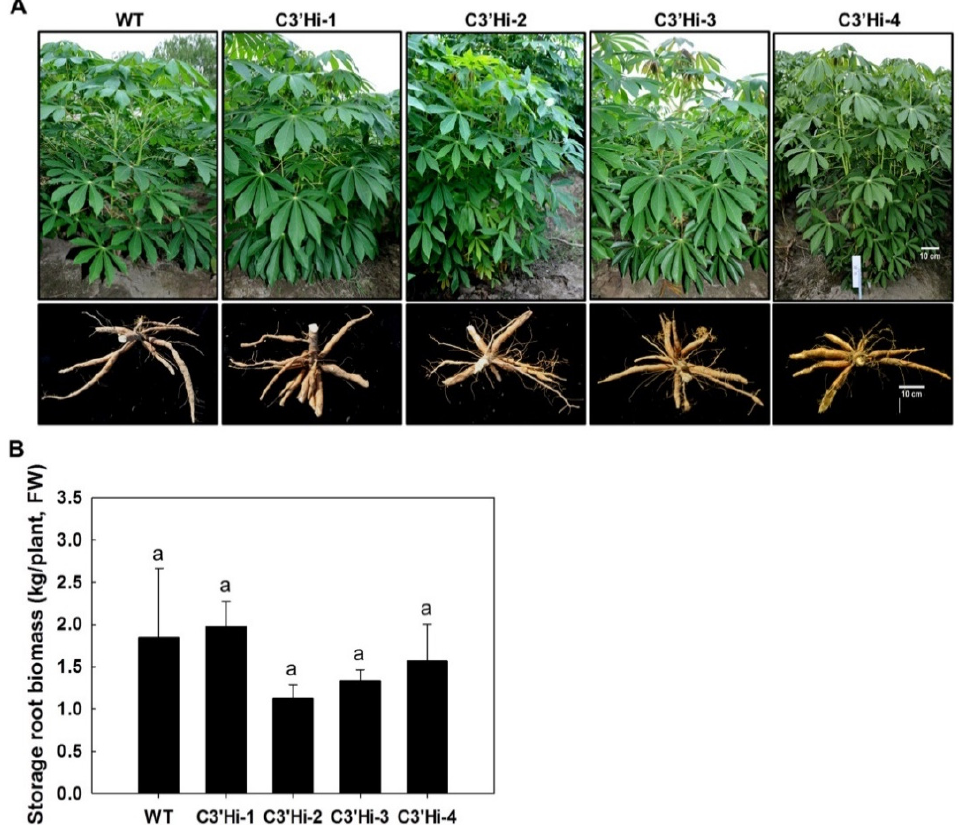
Figure 4. Phenotypes of C3 ′ Hi transgenic plants and WT in the field. ( A ) Phenotypes of the aerial parts (top) and storage roots (bottom) of C3 ′ Hi transgenic plants and WT. ( B ) Yields of storage roots from C3 ′ Hi transgenic plants and WT. Values labeled with ‘a’ at the different time points are not significantly different according to Duncan’s multiple comparison tests at p < 0.05. Bars = 10 cm.